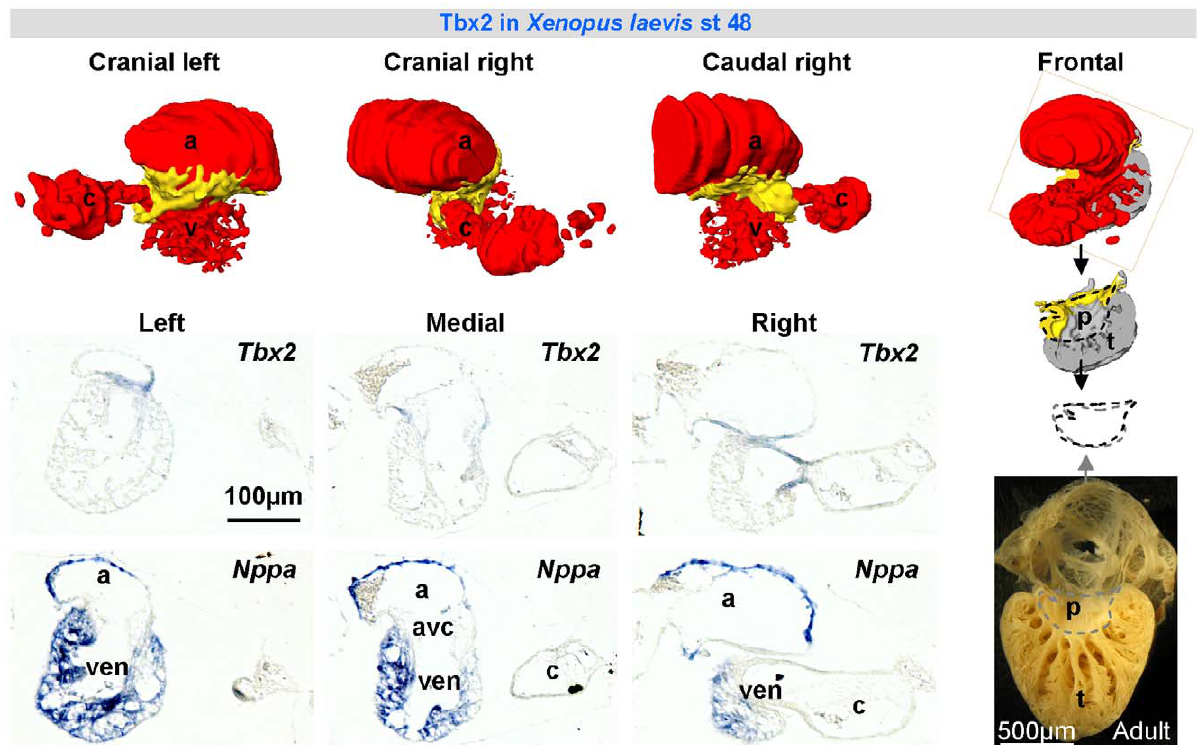
Figure 7. Tbx2 expression (in-situ hybridization) in developing Xenopus (st 48). Tbx2 is expressed in the atrioventricular canal and base of the myocardial outflow tract and complementary to Nppa , marker of chamber myocardium. In ectotherms primitive myocardium (p), remnants of the embryonic heart tube, can be recognized by its smooth surface as opposed to the trabeculated myocardium (t) formed during chamber formation. The primitive myocardium of the ventricular base of st 48 Xenopus hearts already has the adult configuration. The trabecular component is far from fully developed. a, atrium; avc, atrioventricular canal; c, conus arteriosus (myocardial outflow tract); p, primitive (atrabecular) myocardium; t, ventricular trabeculated myocardium; ven,